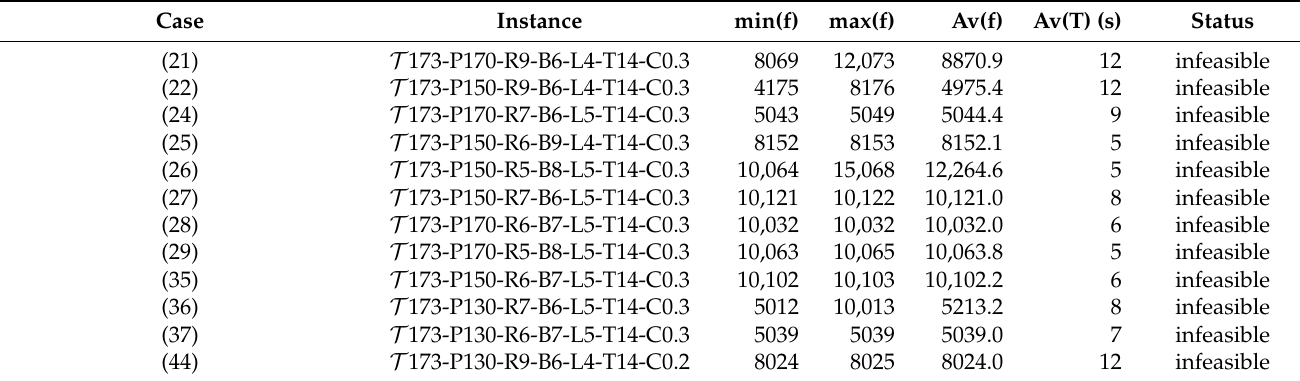
Table 9. Heuristic results for infeasible problem